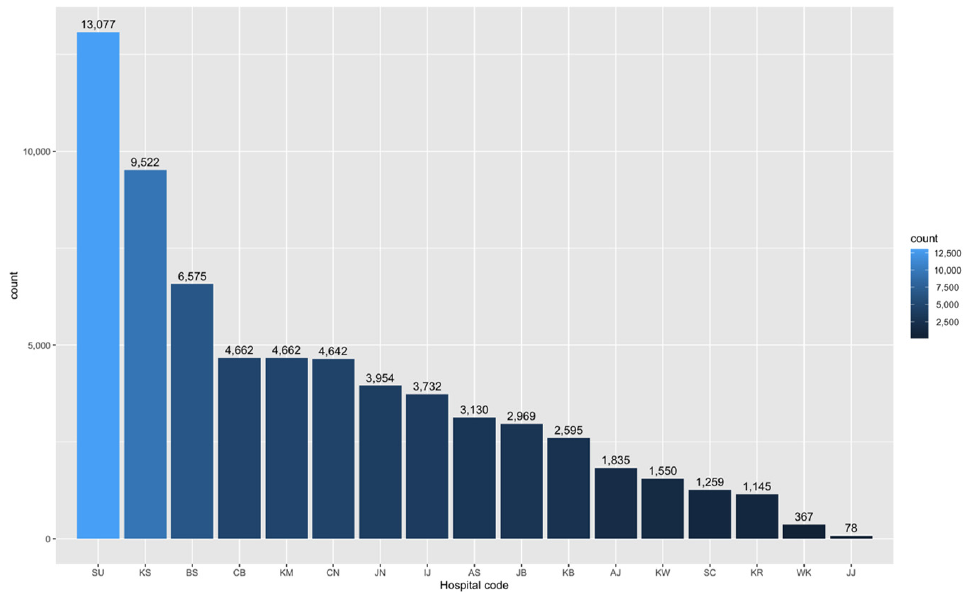
Figure 6. Registered participants by hospital. SU: Seoul National University Hospital, KS: Gyeong-